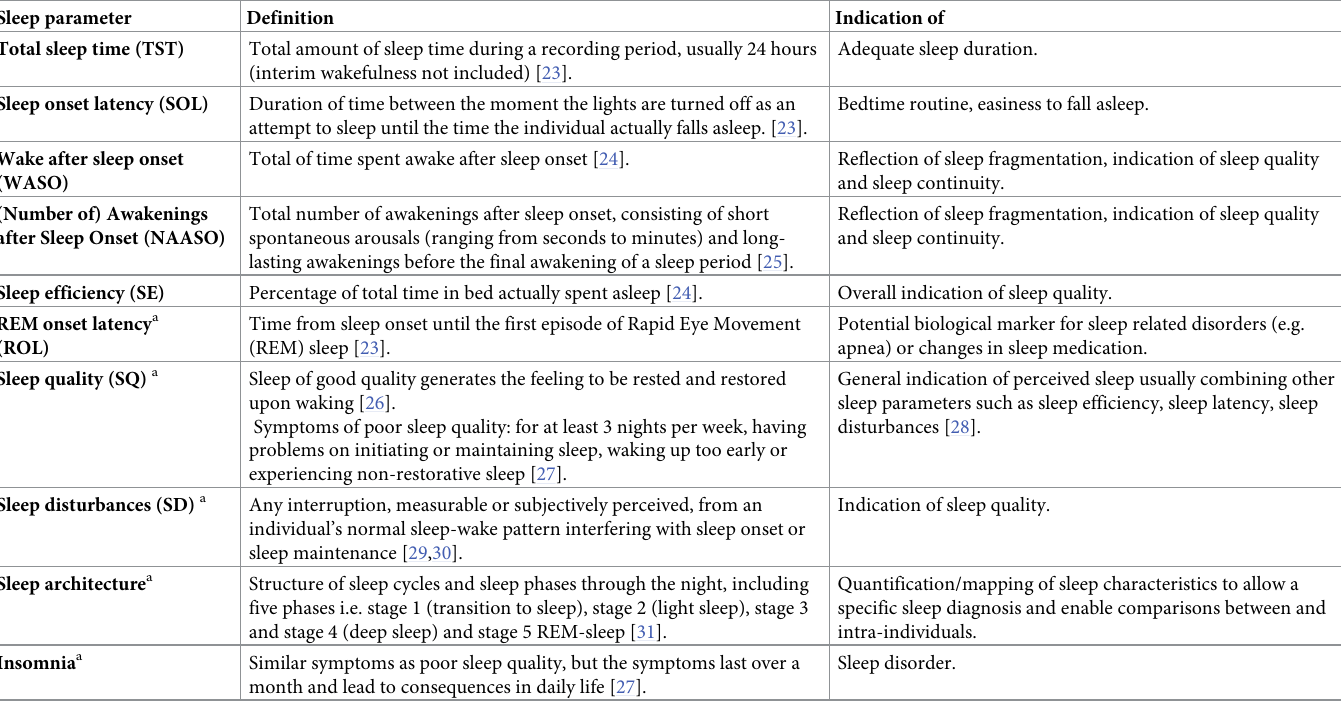
Table 1. Definitions of sleep parameters. Sleep parameter Definition Indication